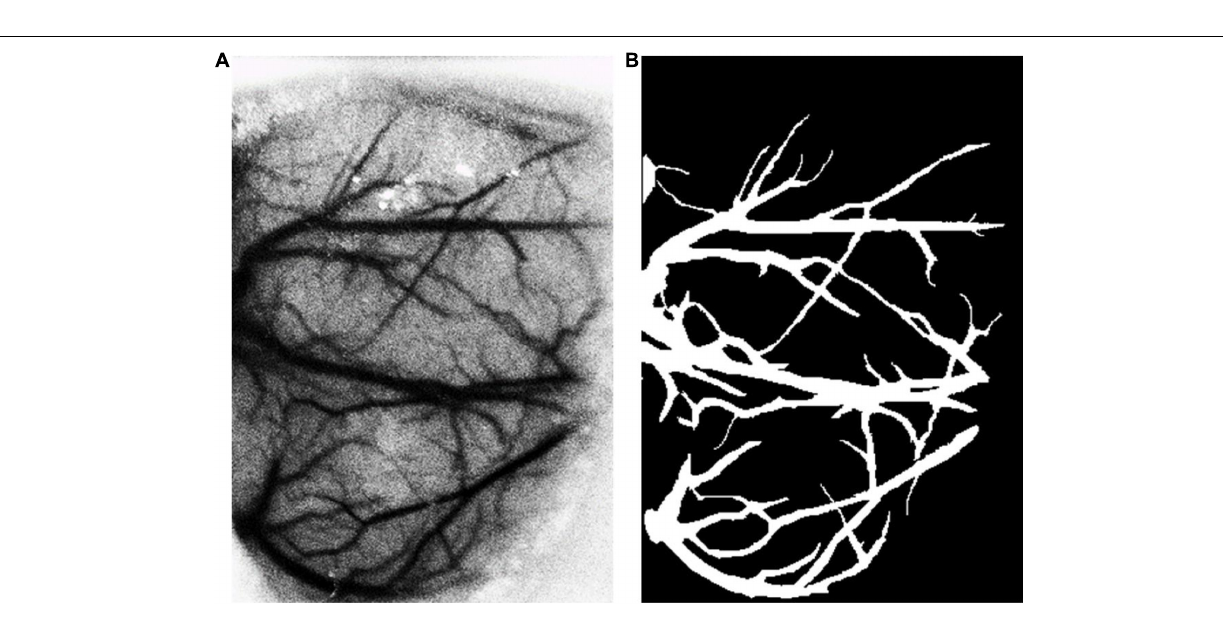
FIGURE 2 | (A) A sample of laser speckle contrast image and (B) its ground truth by manual labeling.